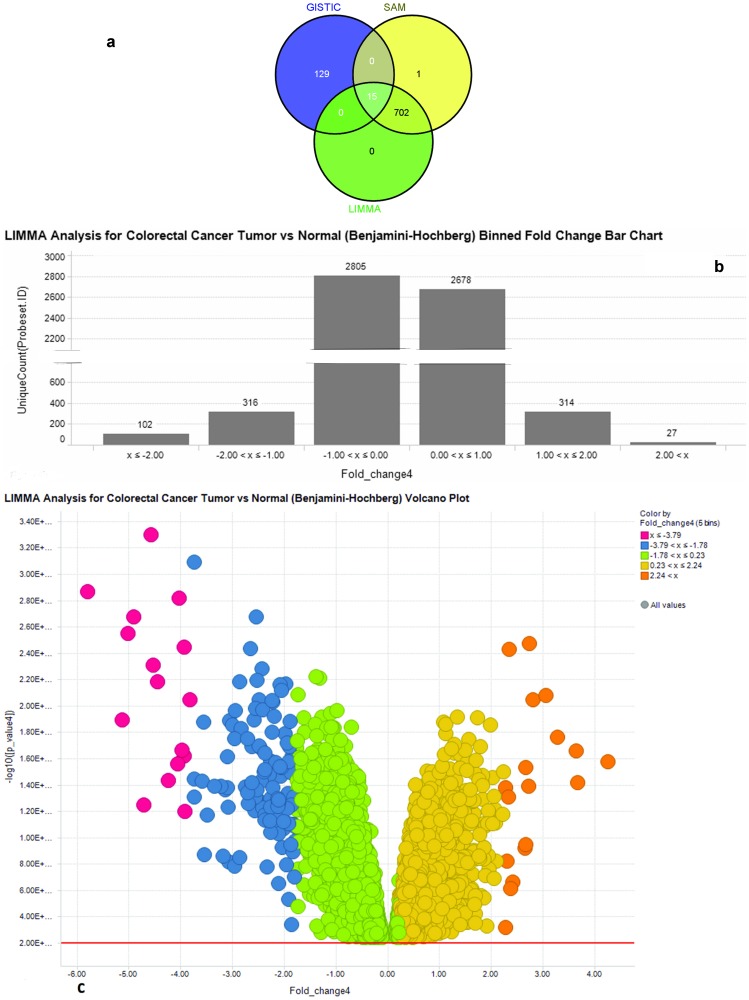
Differential Expression analysis of genes yielded genes common with GISTIC analysis.(a) Venn diagram of common genes among GISTIC, SAM and LIMMA analyses. All genes were annotated and compared using IPA ‘compare’ function. 43 genes from Integromics analyses were not mapped by IPA.15 genes are common among all three analyses. (b) Binned fold change bar chart of LIMMA analysis. Total 6242 genes were having adjusted p-value <0.01 of which 759 showed significant fold change (<−1 or>1). (c) Volcano plot showing highly significant genes (pink  = downregulated, orange = upregulated) in terms of p- value and fold change.